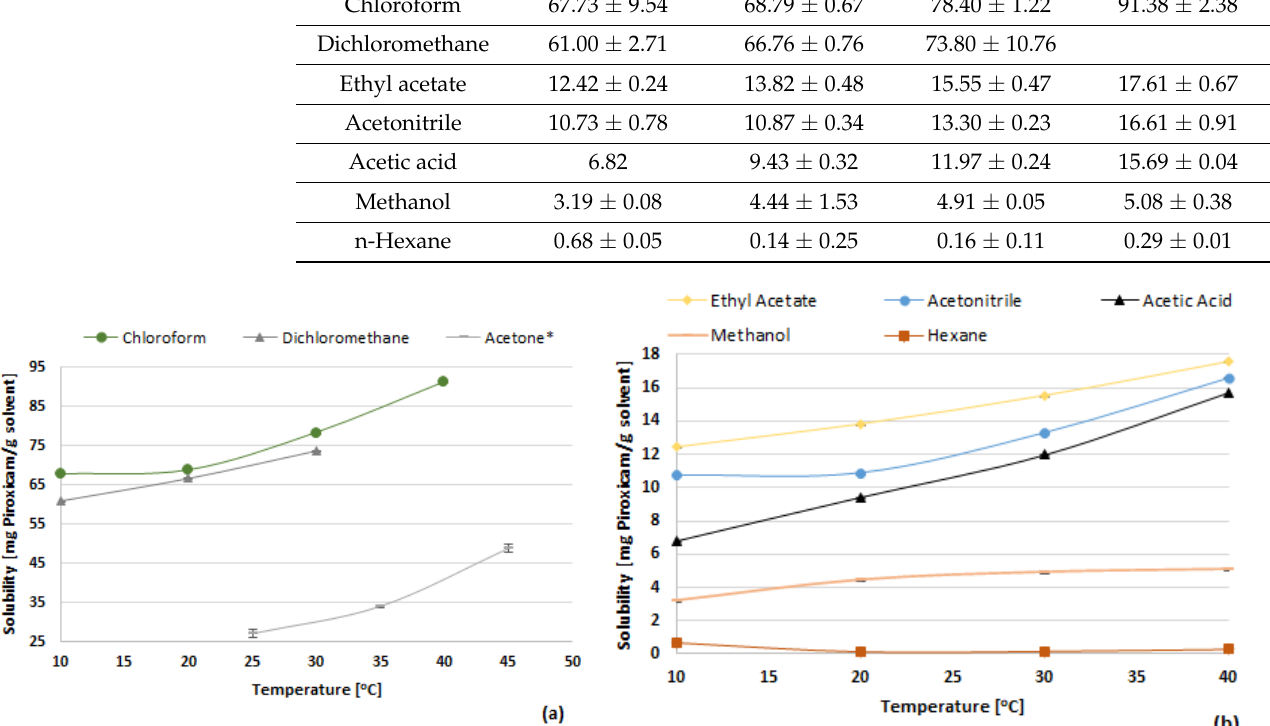
Table 1. Solubility of piroxicam form II in different solvents at varied temperatures (in mg/g solvent). Solvents